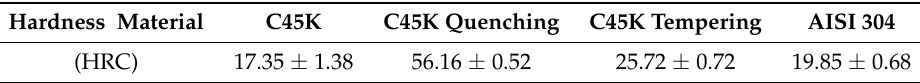
Table 2. Material hardness of metallic alloys.